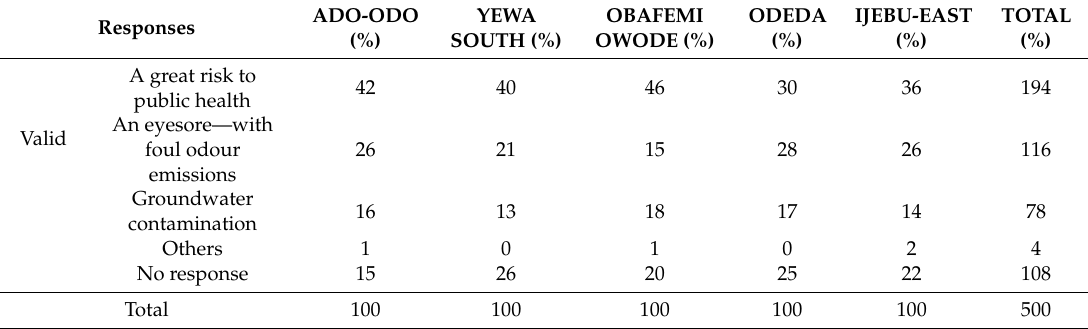
Table 9. Responses on the e ff ects of poor solid waste management (SWM) on the environment.